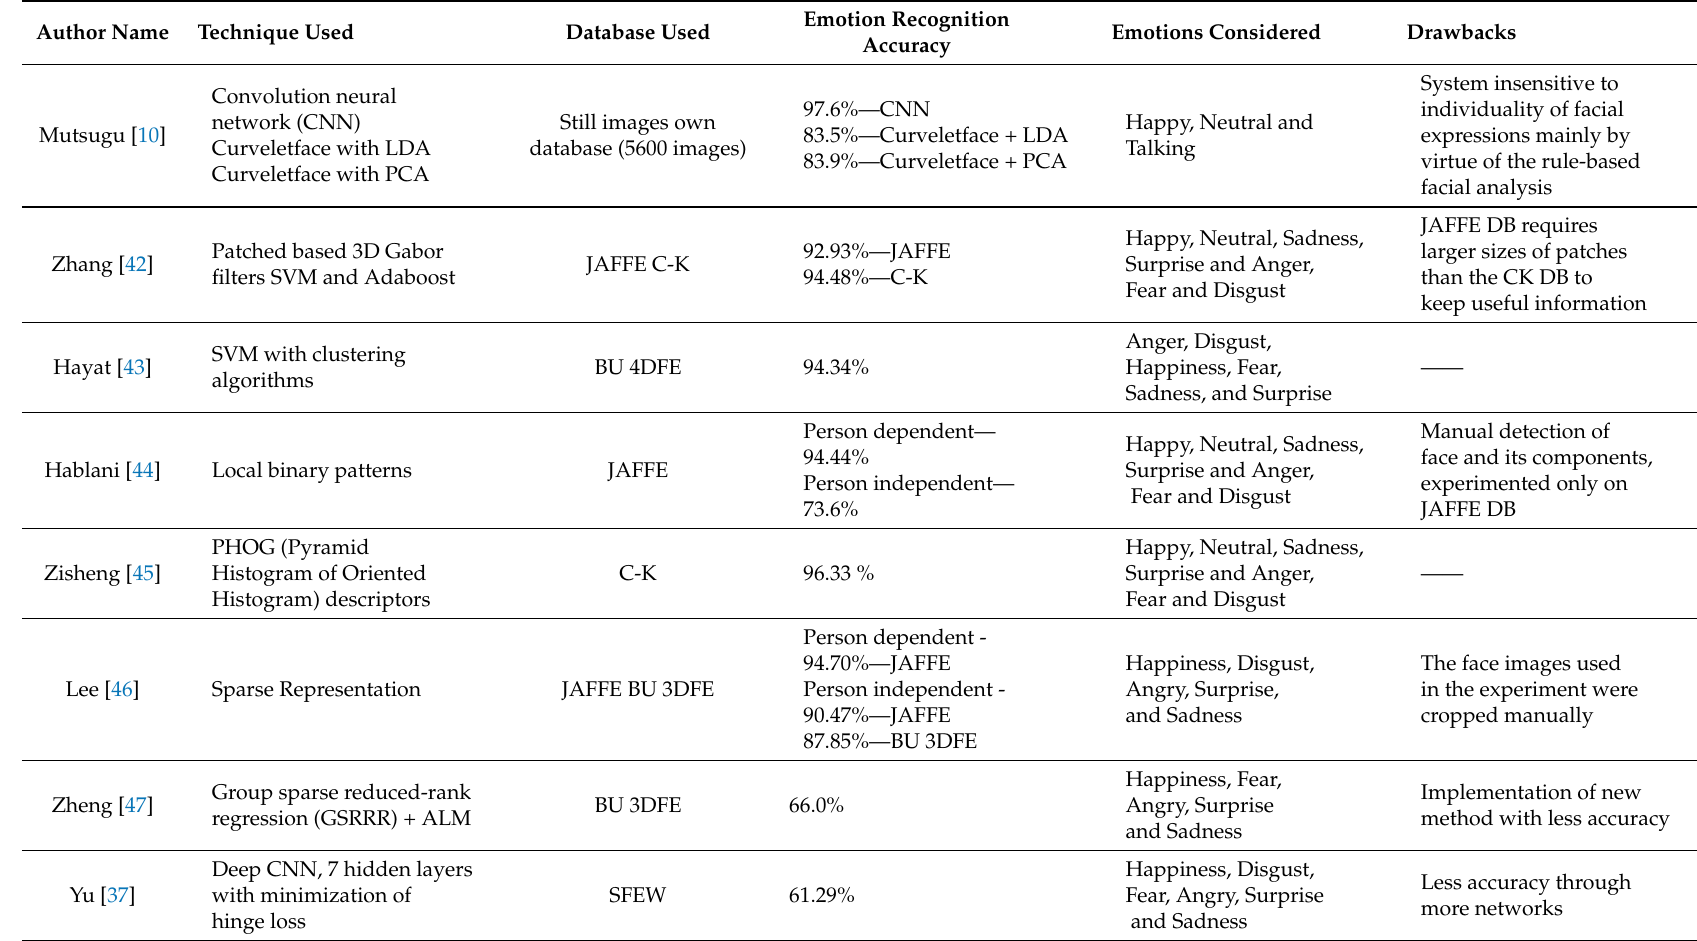
Table 1. Comparison of the accuracies achieved through various